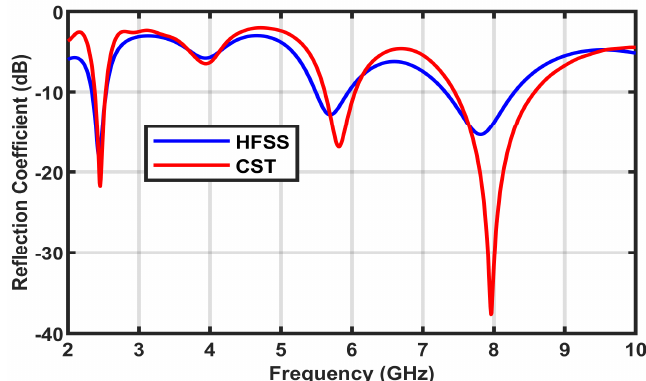
Figure 9. Comparison of the antenna in HFSS and CST.